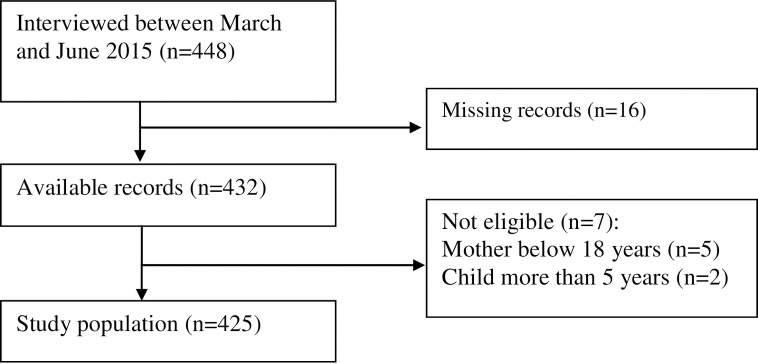
Flow chart showing recruitment of HIV infected women who had a recent delivery and attending care at a rural HIV clinic in Coastal Kenya.